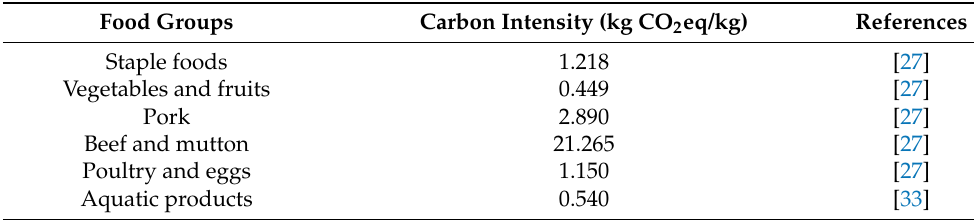
Table 1. Agriculture carbon emission intensities of major food categories. Food